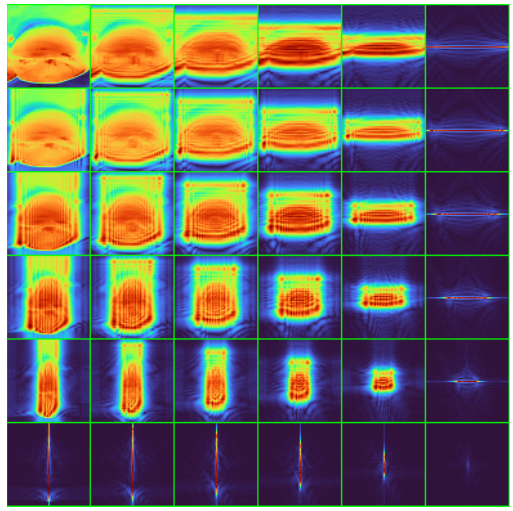
Figure 5. FRFT results of gingivitis images